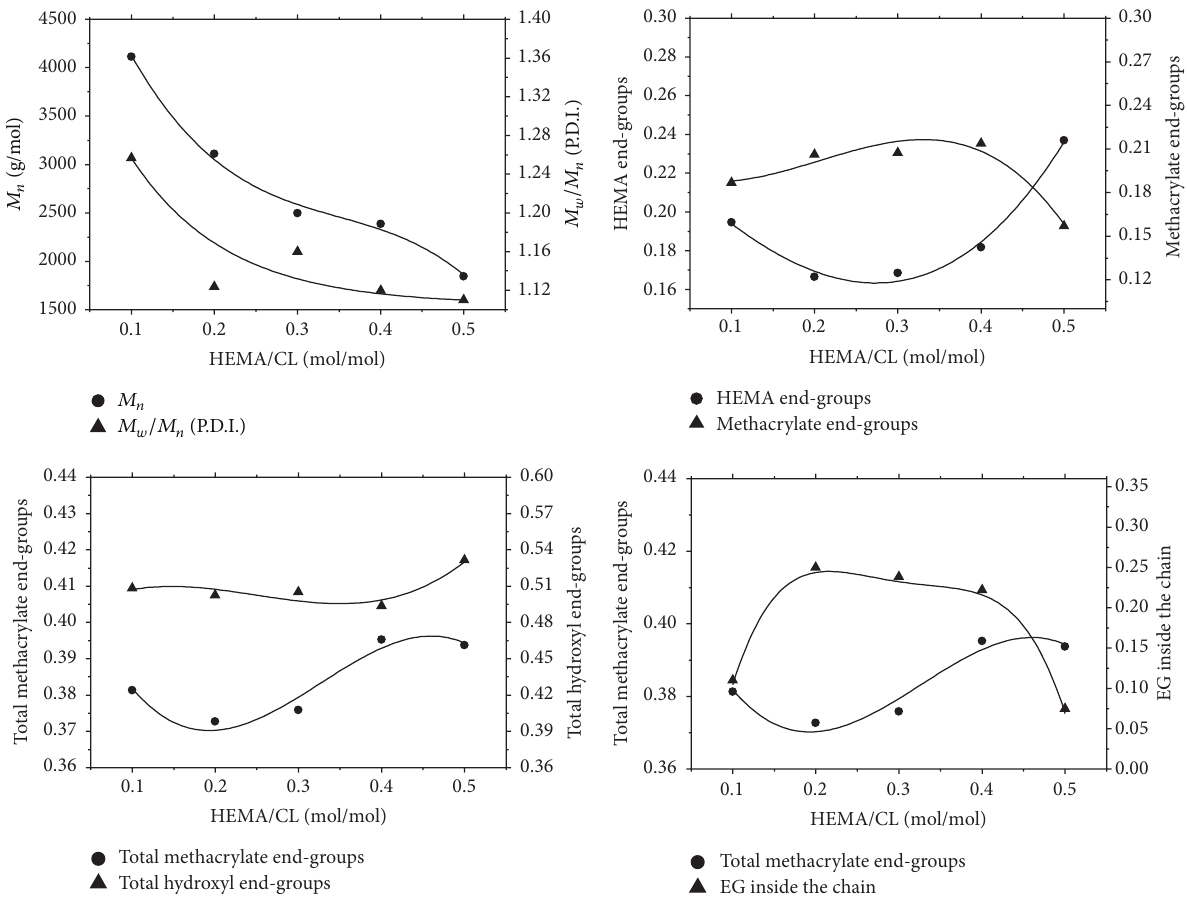
Figure 7: The effect of HEMA/CL on 𝑀 𝑛 , polydispersity, HEMA, methacrylate, total methacrylate, hydroxyl end-groups, and EG inside the chains (Synthesis at 70 ∘ C, 6 hours, 200 mg Novozyme-435, and 9/45 (mmole/mmole) of